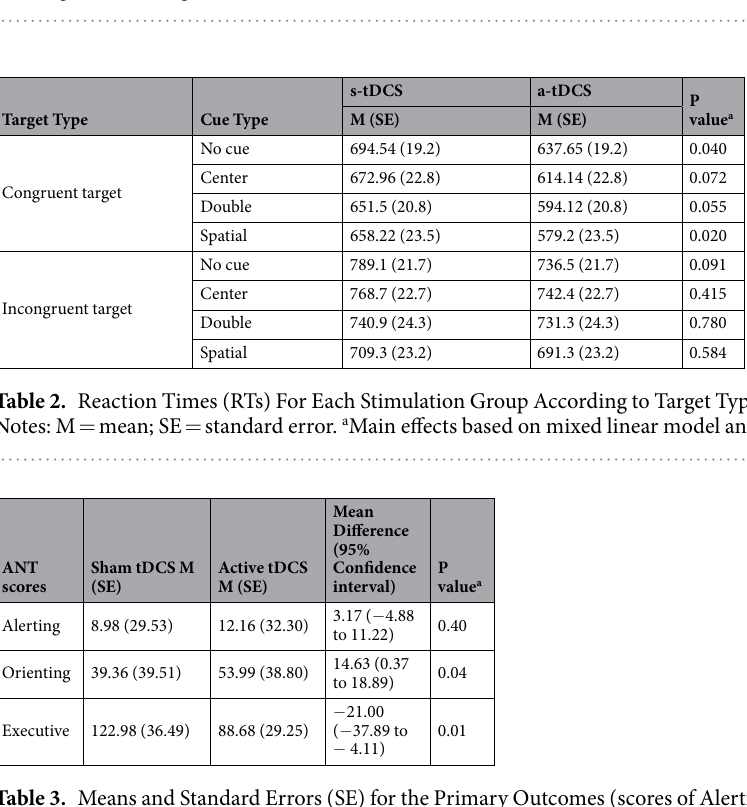
Figure 1. Group differences (main effects) on the ANT scores based on mixed linear model analyses. A: Alerting. B: Orienting. C: Executive. * P < 0,05.